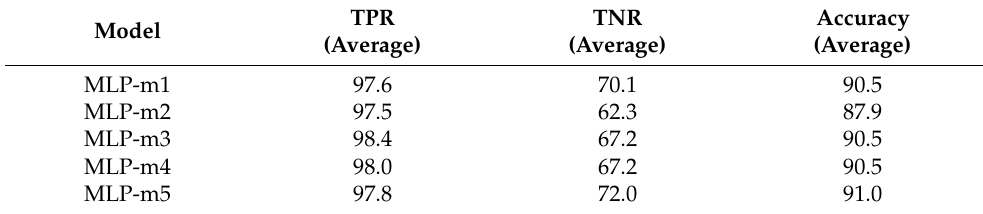
Figure 14. Training results of the MLP-based anomaly detection models: ( a ) TPR and TNR for each model training; ( b ) TNR according to training iteration. Table 9. Test results of MLP-based anomaly detection